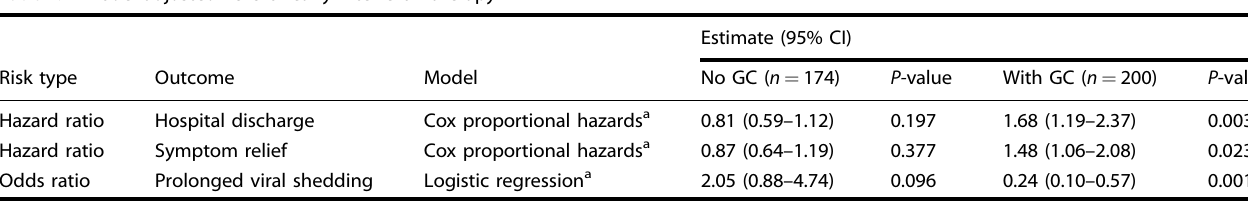
Table 2. Model-adjusted risks of early interferon therapy